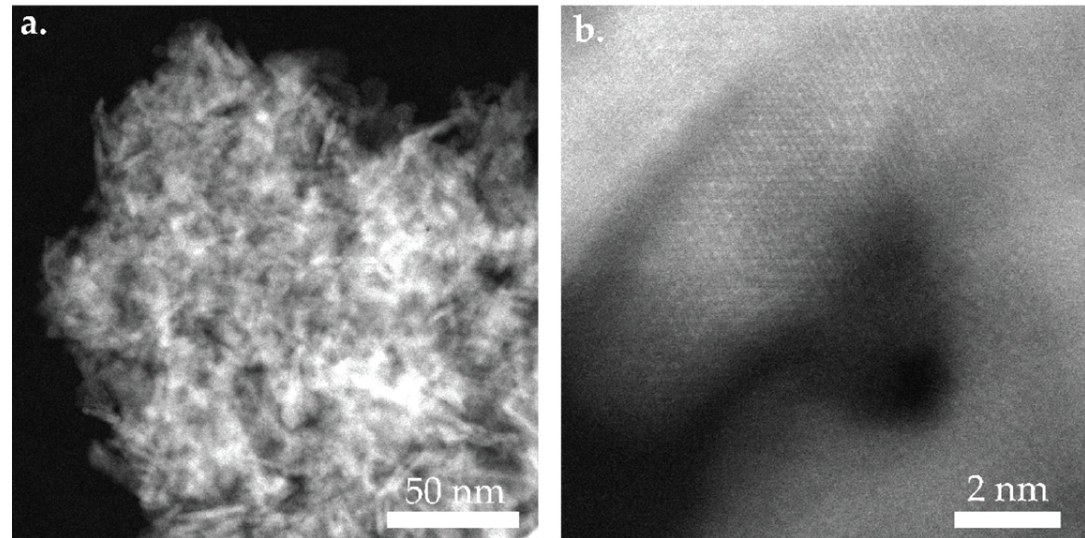
Figure 2. Representative High-Angle Annular Dark-Field Scanning Transmission Electron Microscopy micrographs of gold nanoparticles supported on γ -Al 2 O 3 ( a ) at low magnification, ( b ) at high magnification.